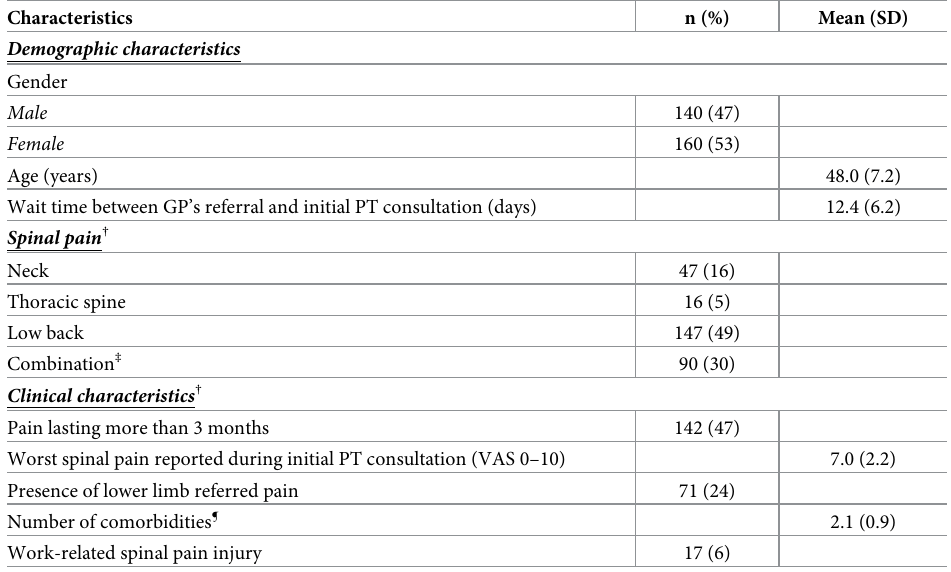
Table 2. Characteristics of new patients with spinal pain complaint included from the caseload of participating physiotherapists (n = 300).